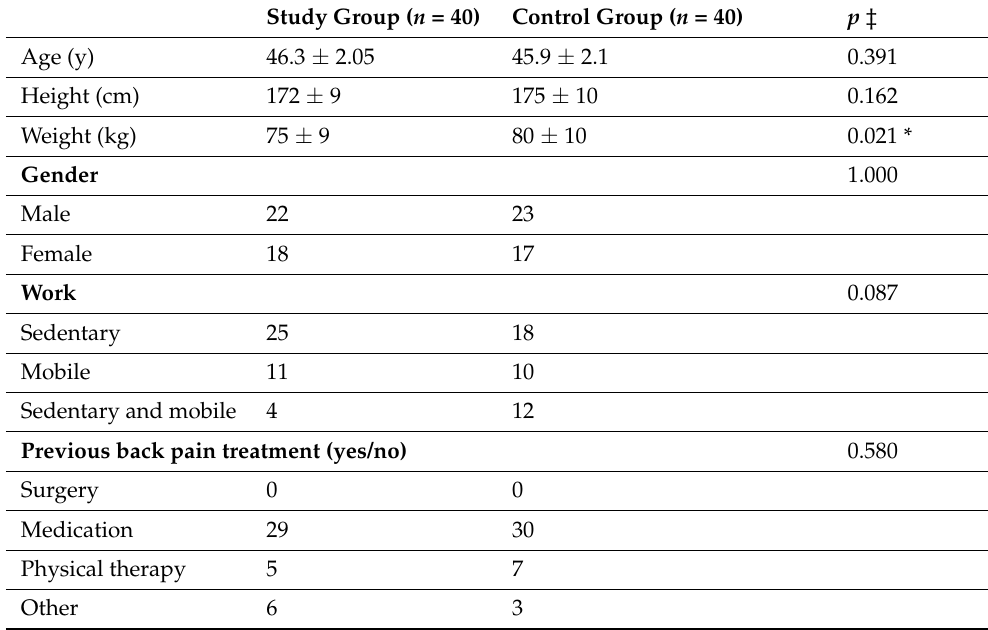
Table 1. Baseline participant demographics and tests of significance of between group